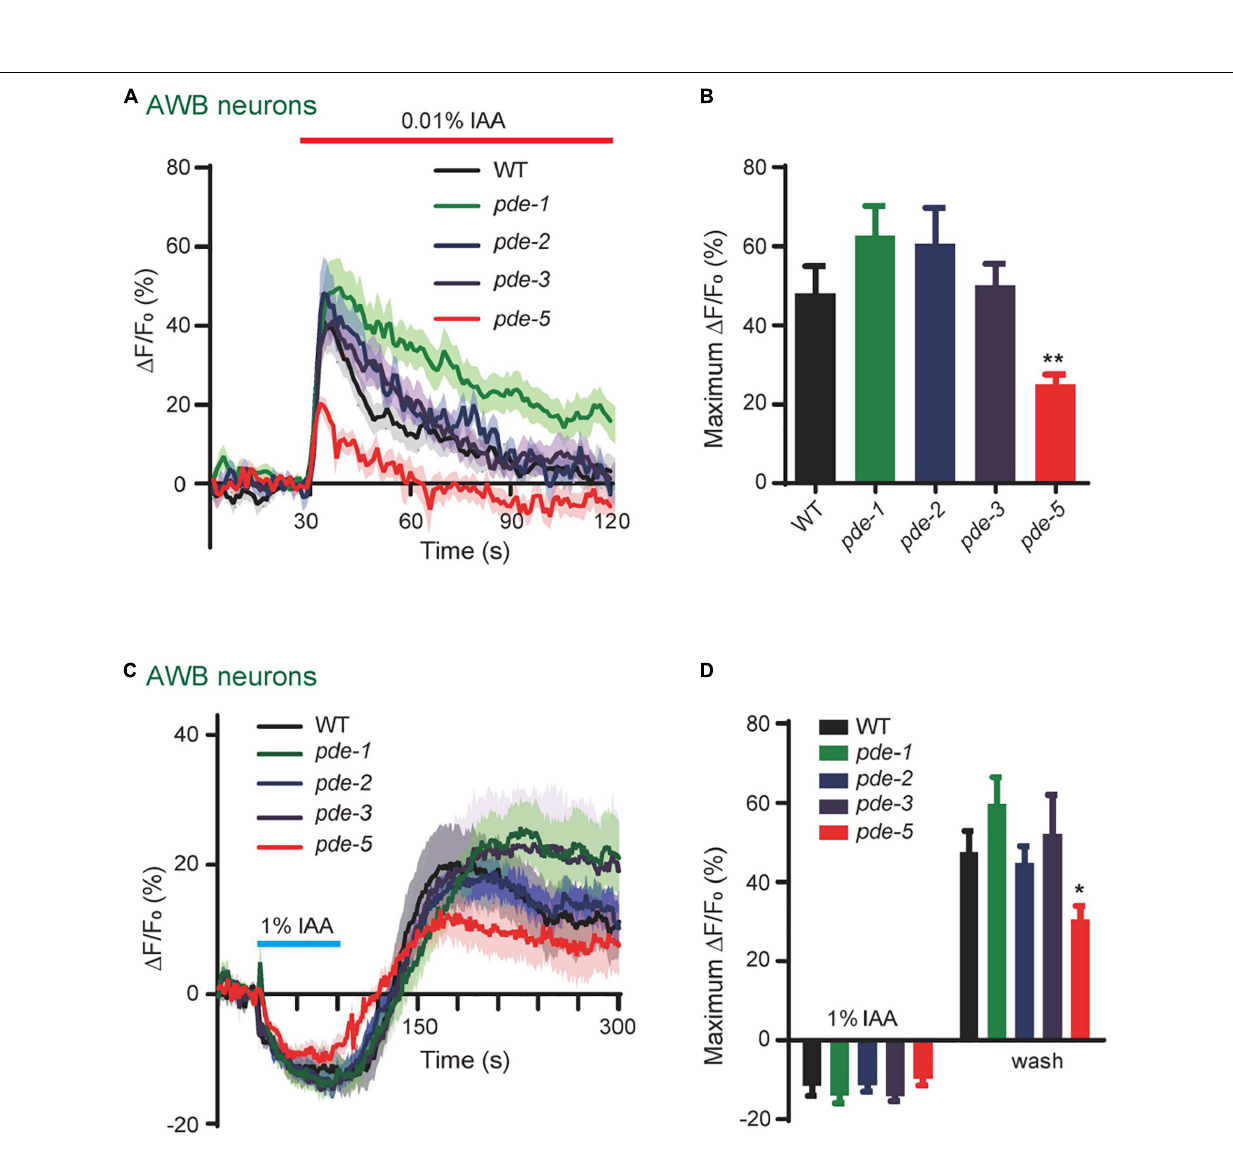
Frontiers in Molecular Neuroscience |